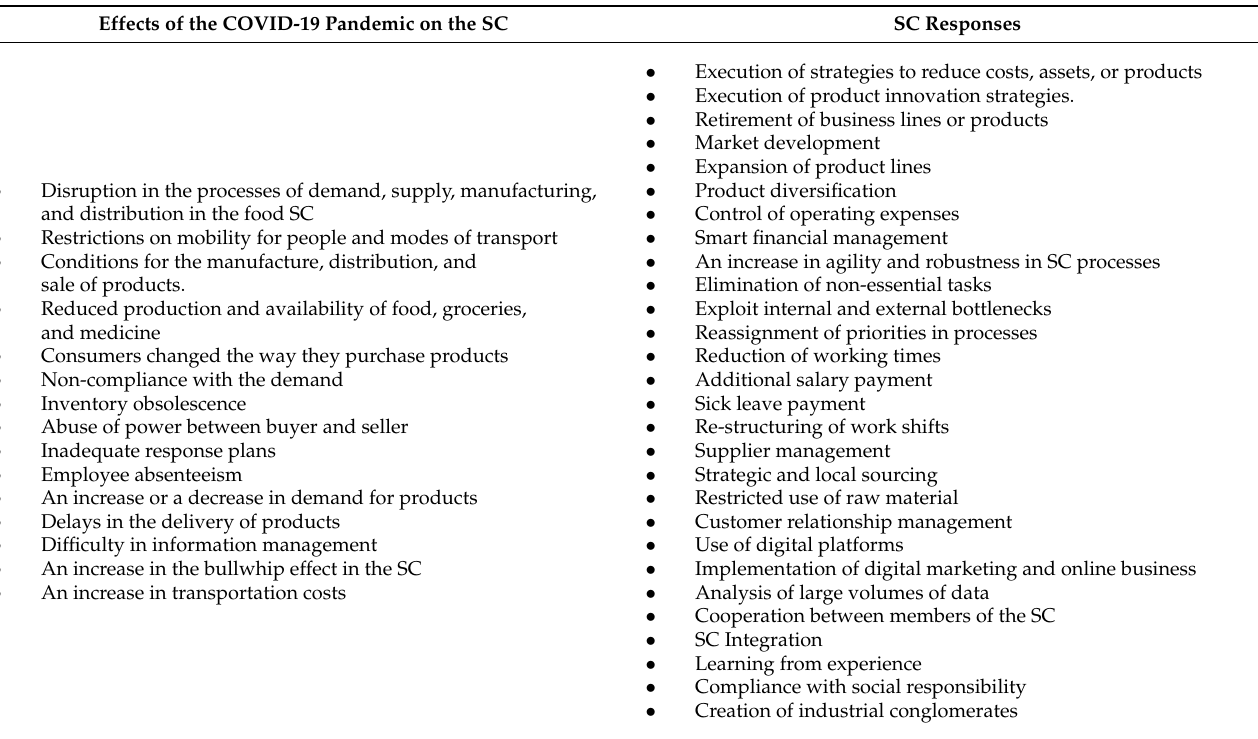
Table 1. Effects of COVID-19 and SC